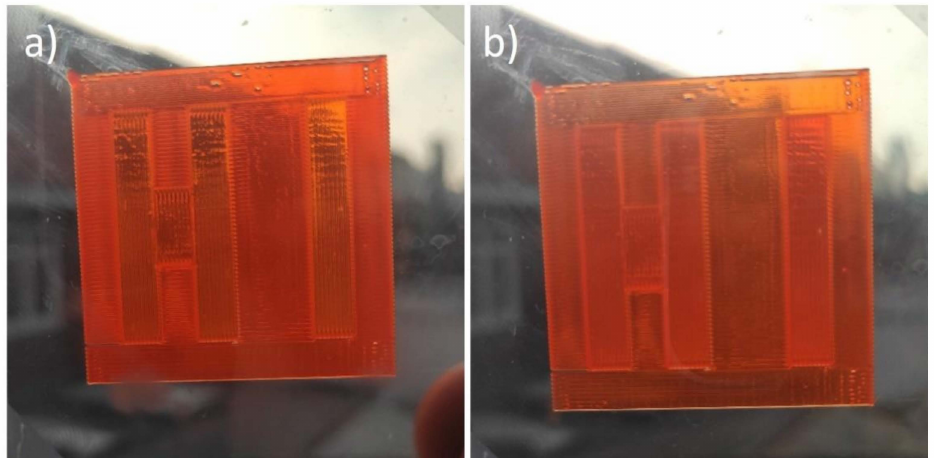
Figure 5. Direct ink-written LSC-type sample with LC oligomer containing DCM dye printed in two different directions viewed through a linear polarizer with absorption axis oriented ( a ) 0 ◦ and ( b ) 90 ◦ to the printing direction of the text.